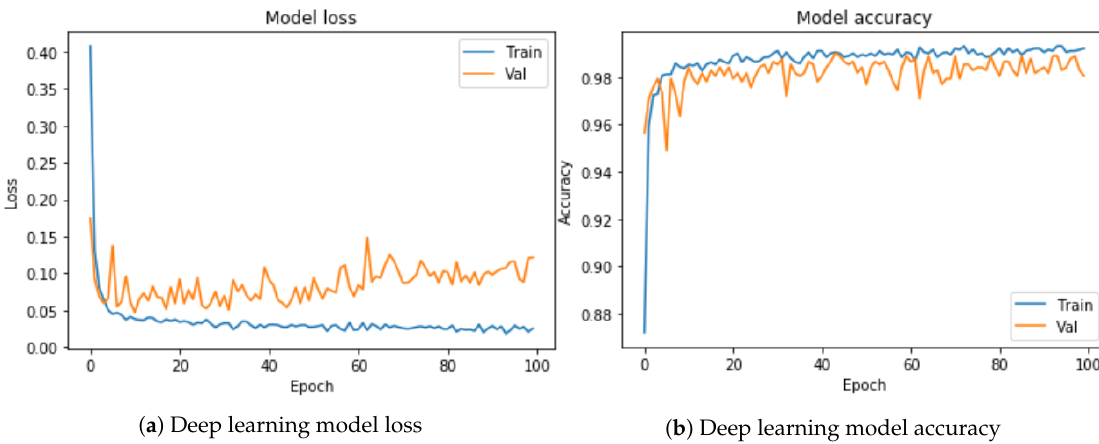
Figure 6. Deep learning model loss and classification